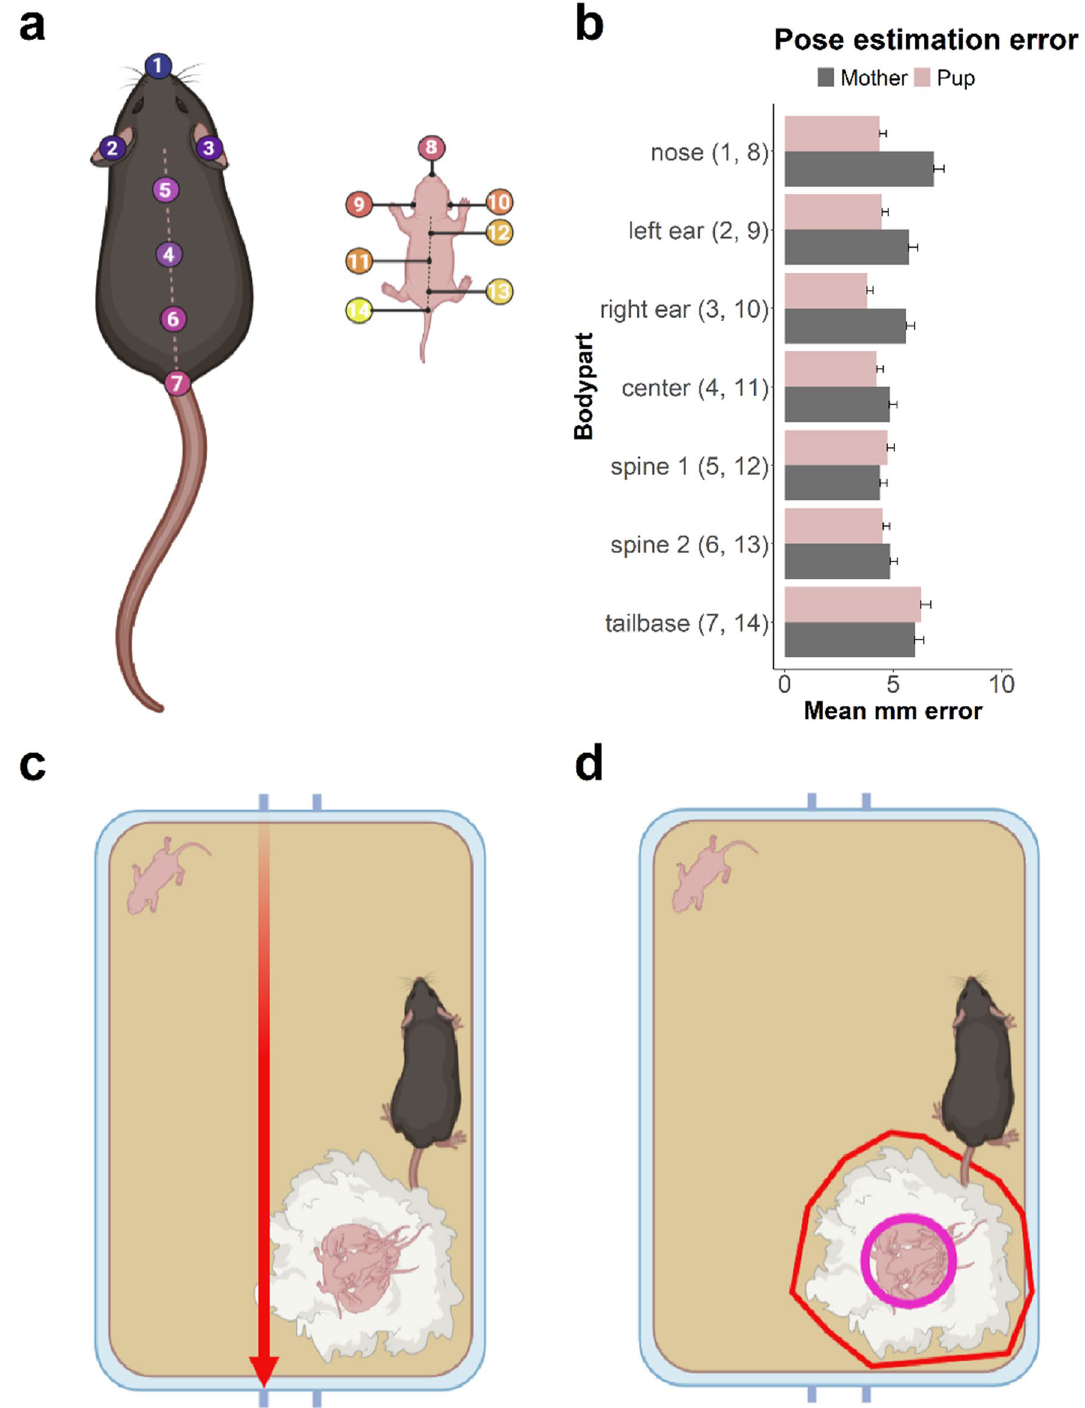
Figure 1. Pose estimation and region of interest (ROI) definition. ( a ) Schematic representation of the 14-body part pose configuration used for the PRT protocol in DeepLabCut (image was created with BioRender.com). ( b ) Mean millimeter error per body part and subject for the DeepLabCut PRT pose estimation model. Means were calculated without the use of an estimation p-cutoff. In Supplementary File 2 Table S2, the mean mm errors are shown with different p-cutoff values. ( c ) Illustration of distance on a Type-II mouse cage. We used the length between opposite cage tag hinges as standard length. The pink line indicates a distance of 267 mm. ( d ) Example of region of interest (ROI) definition in SimBA. The yellow area indicates the nest site and the pink circular area the core nest. The red markers do not display any ROI, but indicate that the top corners of the home cage need to be visible in the cropped